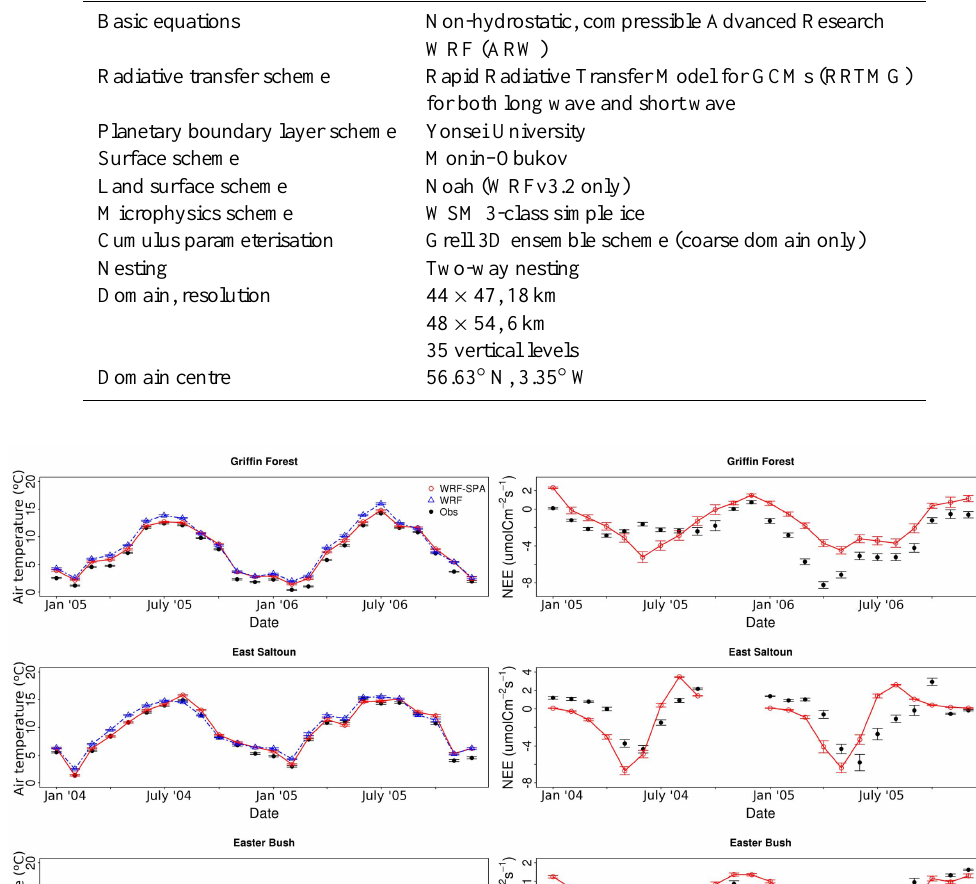
Table 2. Parameter and model options used in both WRF-SPA and WRF.